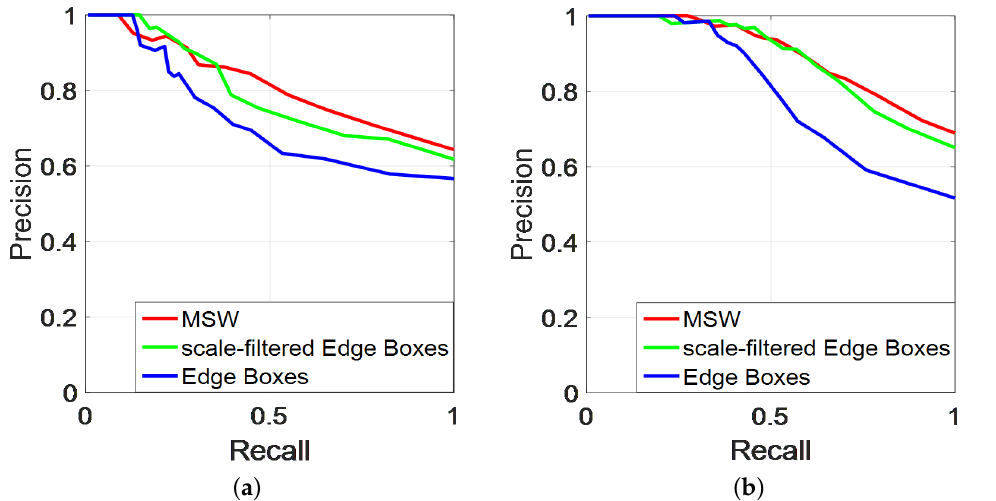
Figure 10. Results of MSW, scale-filtered Edge Boxes and original Edge Boxes for place recognition on: ( a ) Mapillary Berlin; and ( b ) Freiburg Across Seasons